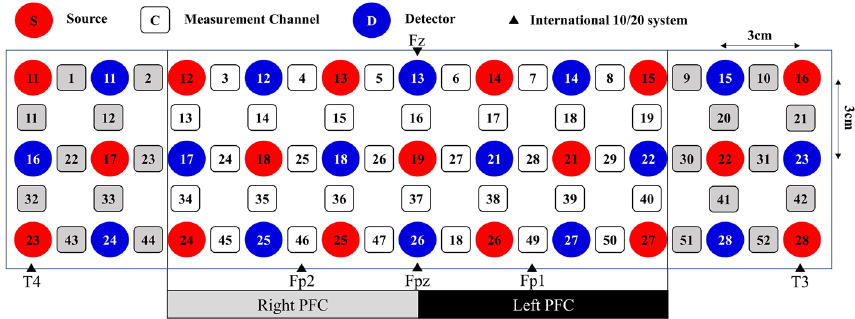
Figure 6. Probes were setup on subjects’ forehead and scalp based on the international 10/20